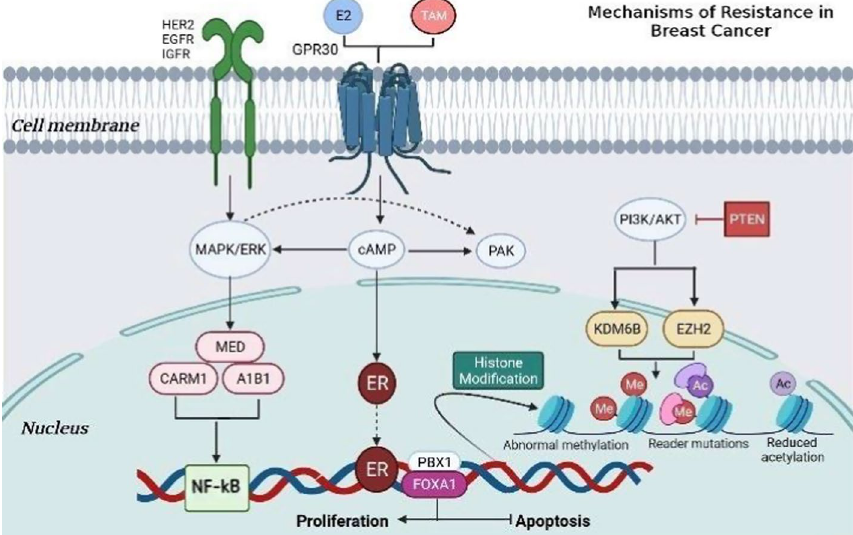
Fig. 3 mechanism of resistance to endocrine therapy with tamoxifen (TAM) in breast cancer. Increasing the expression and activity of tyrosine kinase receptor family proteins, such as HER2, EGFR, IGFR, and GPR30,